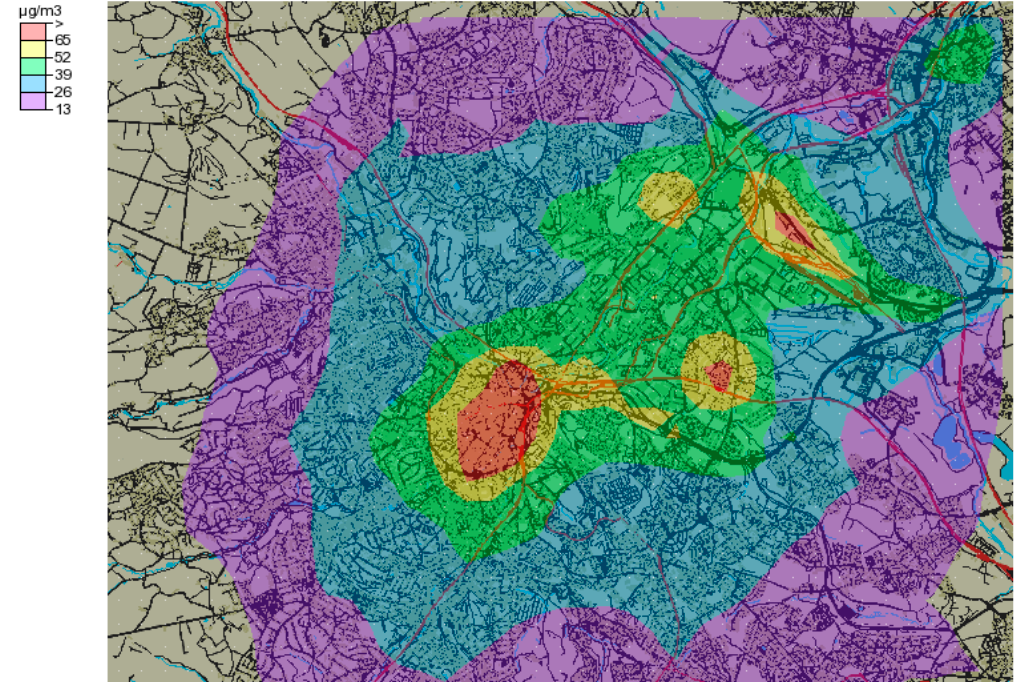
Figure 5. Estimated annual mean NOx concentrations (µg/m 3 ) using all emission sources in Sheffield for year 2017.